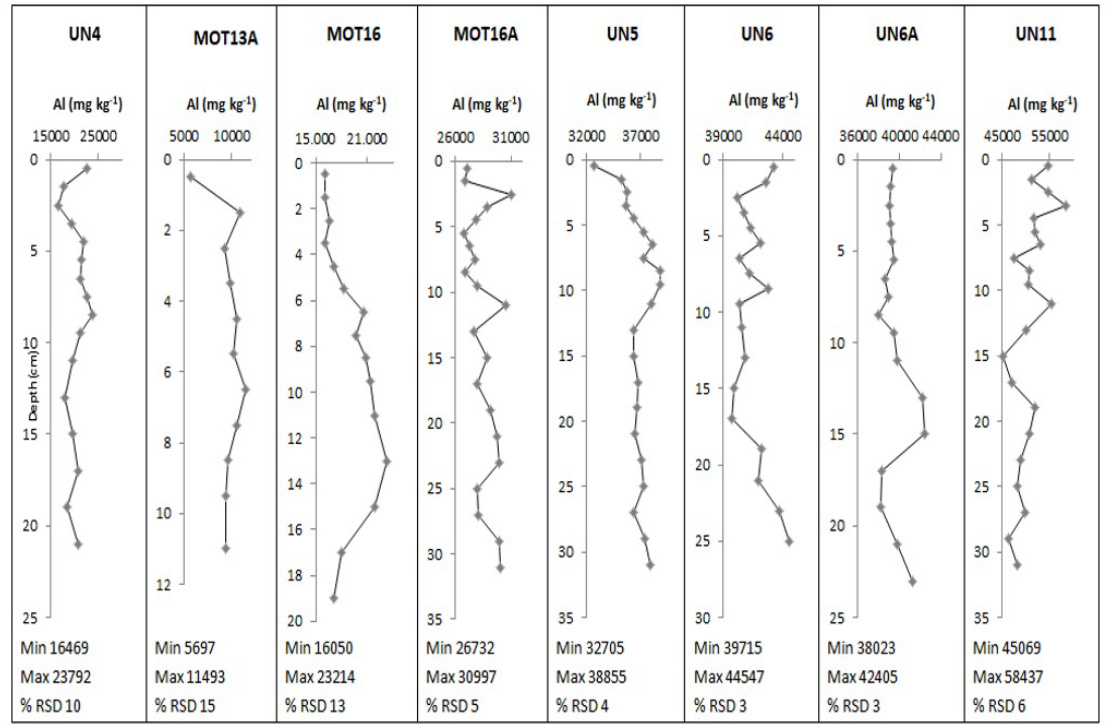
Figure A1. Vertical distributions of Al (in mgkg − 1 ) in sediment cores. The concentrations in the coarse cores MOT13A, MOT16 and UN4 refer to the total sediment fraction ( < 1mm).